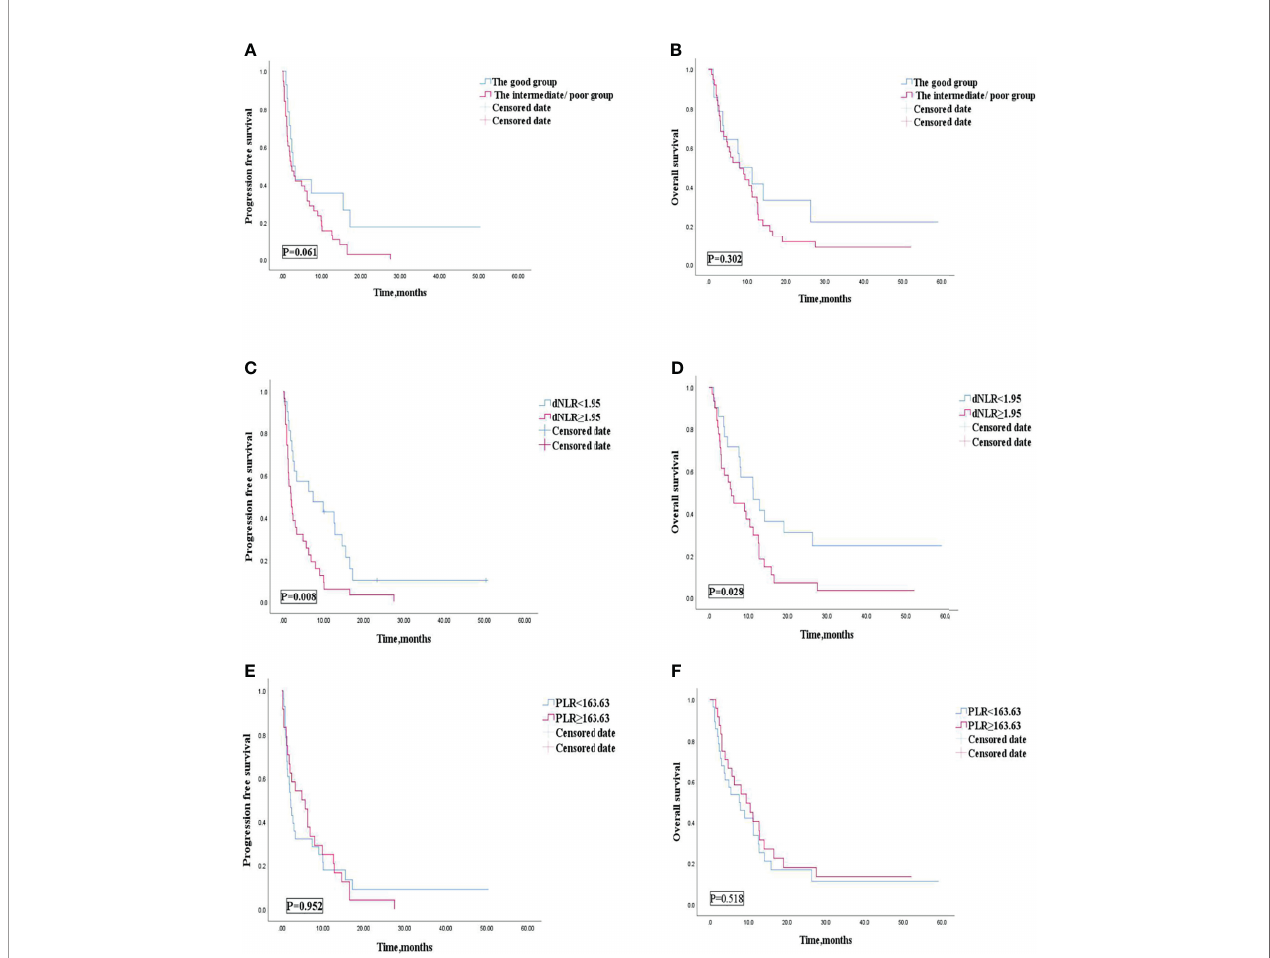
FIGURE 7 | PFS (A) and OS (B) of the good group and the intermediate/poor group of patients with AGC, receiving ICIs monotherapy cohort, OS (C) and PFS (D) of the dNLR of patients with AGC, receiving ICIs monotherapy cohort, and OS (E) and PFS (F) of the PLR of patients with AGC, receiving ICIs monotherapy cohort. PFS, progression-free survival; OS, overall survival; ICIs, immune checkpoint inhibitors; dNLR, derived neutrophil ‐ to ‐ lymphocyte; PLR, platelet – lymphocyte